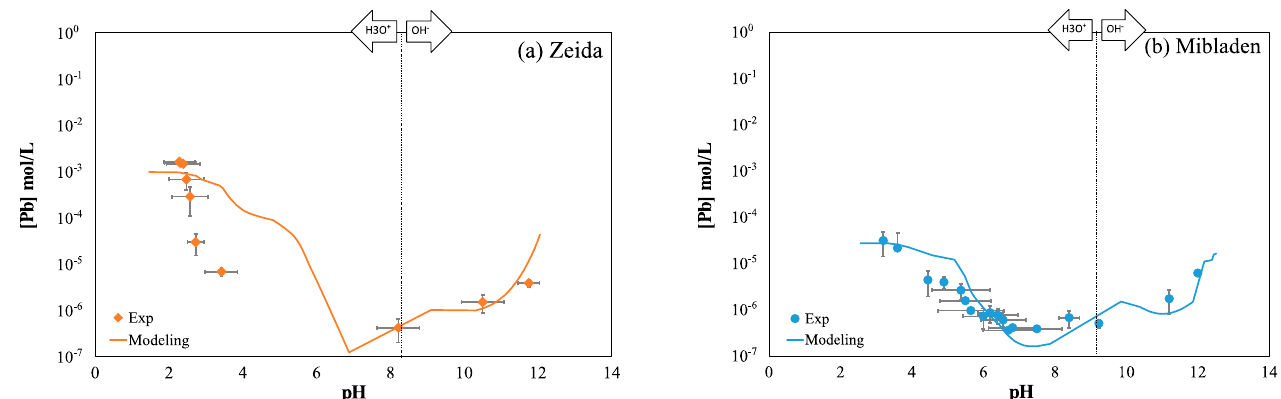
Figure 4. Solubilization of lead (total dissolved concentration), as a function of pH, from Zeida ( a ) and Mibladen ( b ) mine tailings; experimental curves (cross, adapted from [1,32]) and geochemical modeling (solid line).